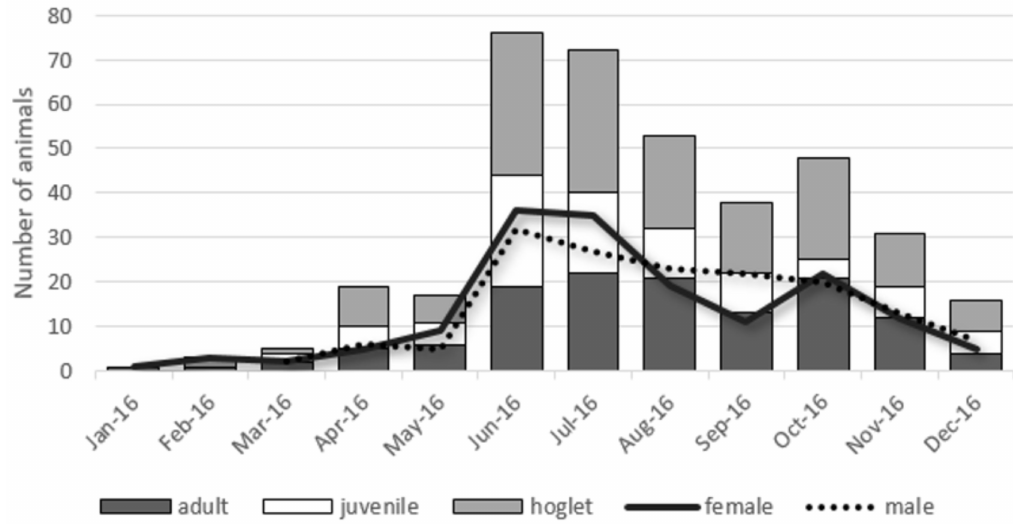
Figure 2. Distribution of hedgehog arrivals over the year according to their age groups (bars) or sex (lines). During the clinical examination on arrival, we observed ectoparasites such as fleas ( Archaeopsylla erinacei ) and ticks ( Ixodes sp.) on most animals, with variable degrees of infestation. The hedgehogs with the poorest body condition on arrival were found system- atically infested by Calliphoridae (Diptera) eggs and/or larvae (responsible for cutaneous myiasis). Thirty-two out of 412 hedgehogs (8%) showed skin lesions such as scaly skin, loss of spines or alopecia, with different degrees of severity (Figure 3). Skin scrapings were performed on animals showing itching, crusty skin and erythema on arrival. The presence of mites ( Caparinia tripilis and Sarcoptes scabiei ) was observed in two animals, respectively.